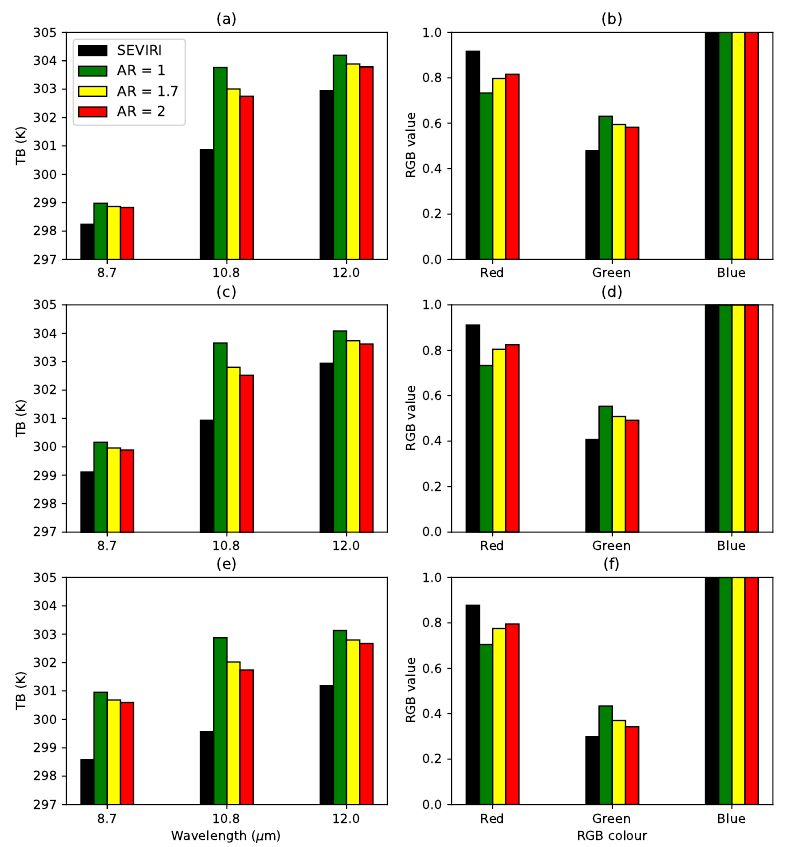
Figure 11. Mean brightness temperatures (left column) and RGB colours (right column) across the domain for the three ranges of surface emissivity values, for the SEVIRI measurements and retrievals and tested for the VO73 dust simulations with the three (horizontally aligned) aspect ratios of 1, 1.7, and 2, for the June and July of 2011–2013. Only points with AODs between 2 and 3 are included. Using emissivity at 8.7µm, the panels are: (a, b) emissivity from 0.7–0.8; (c, d) 0.8–0.9; (e, f)